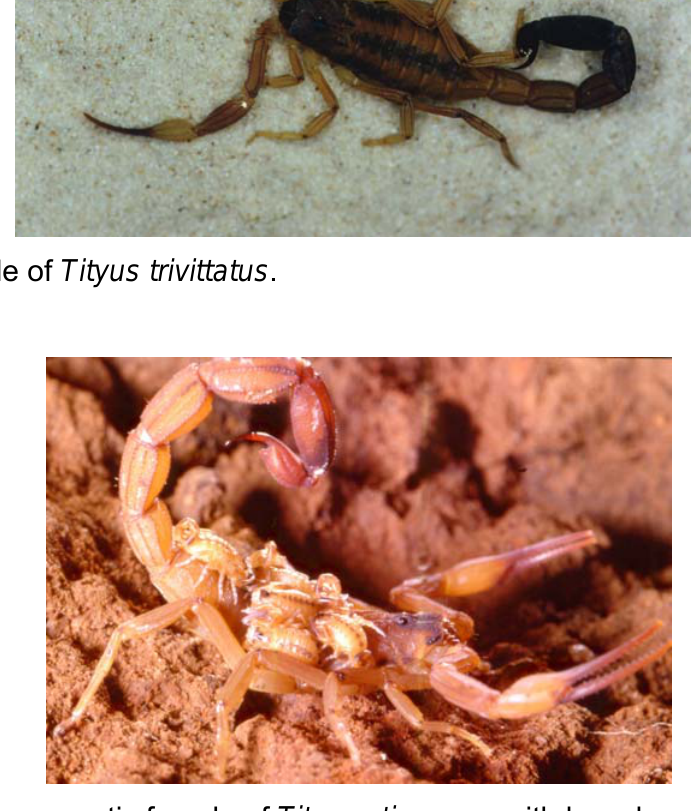
Figure 7. Parthenogenetic female of Tityus stigmurus with